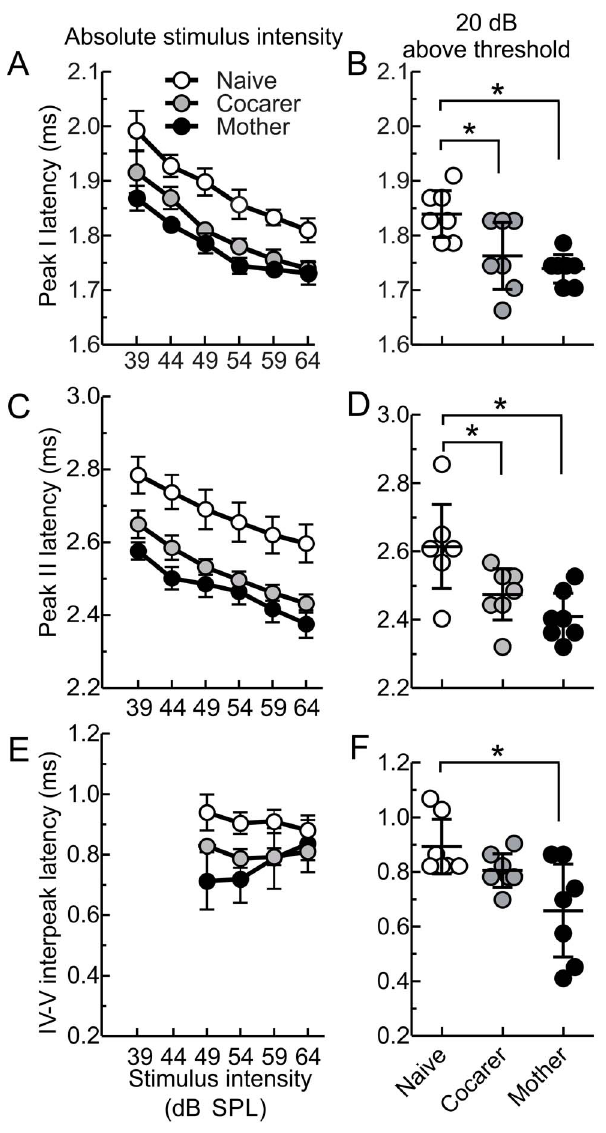
Figure 2. Click-evoked ABR latencies for specific peaks are significantly shorter for mothers than pup-naive females, with cocarers more similar to mothers. A) Latency to peak I at different absolute sound intensities (latency intensity function, LIF) and B) at 20 dB above ABR threshold. C) LIF for peak II and D) peak II latency at 20 dB above ABR threshold. E) LIF for interpeak latencies between peaks IV and V. No data points are shown for 39 and 44 dB SPL as this peak was not consistently present in all animals at lower stimulus intensities. F) interpeak latencies between peaks IV and V at 20 dB above auditory brainstem response threshold. LIFs in A), C) and E) show means with error bars denoting SEM. Dots in B), D) and F) show individual latencies for each animal with the middle bar representing the mean and error bars denoting 95% confidence intervals. Asterisks indicate statistical significance at p , 0.010 in B) and p , 0.013 in D) for the indicated post-hoc comparisons, using the Sidak adjusted alpha level.